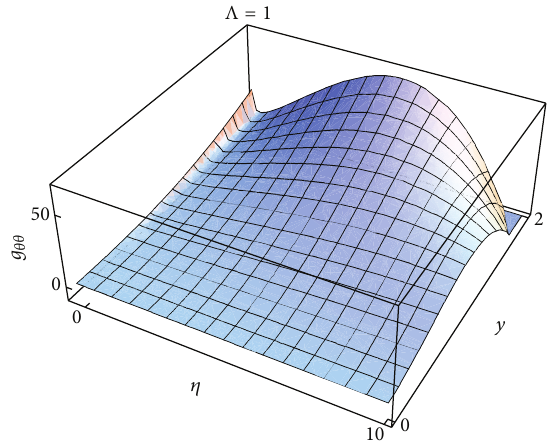
Figure 2: Black string warped horizon area 𝑔 𝜃𝜃 (𝑅,𝑦) along the extra dimension for Λ = 1 and the parameter 𝜂 variable.